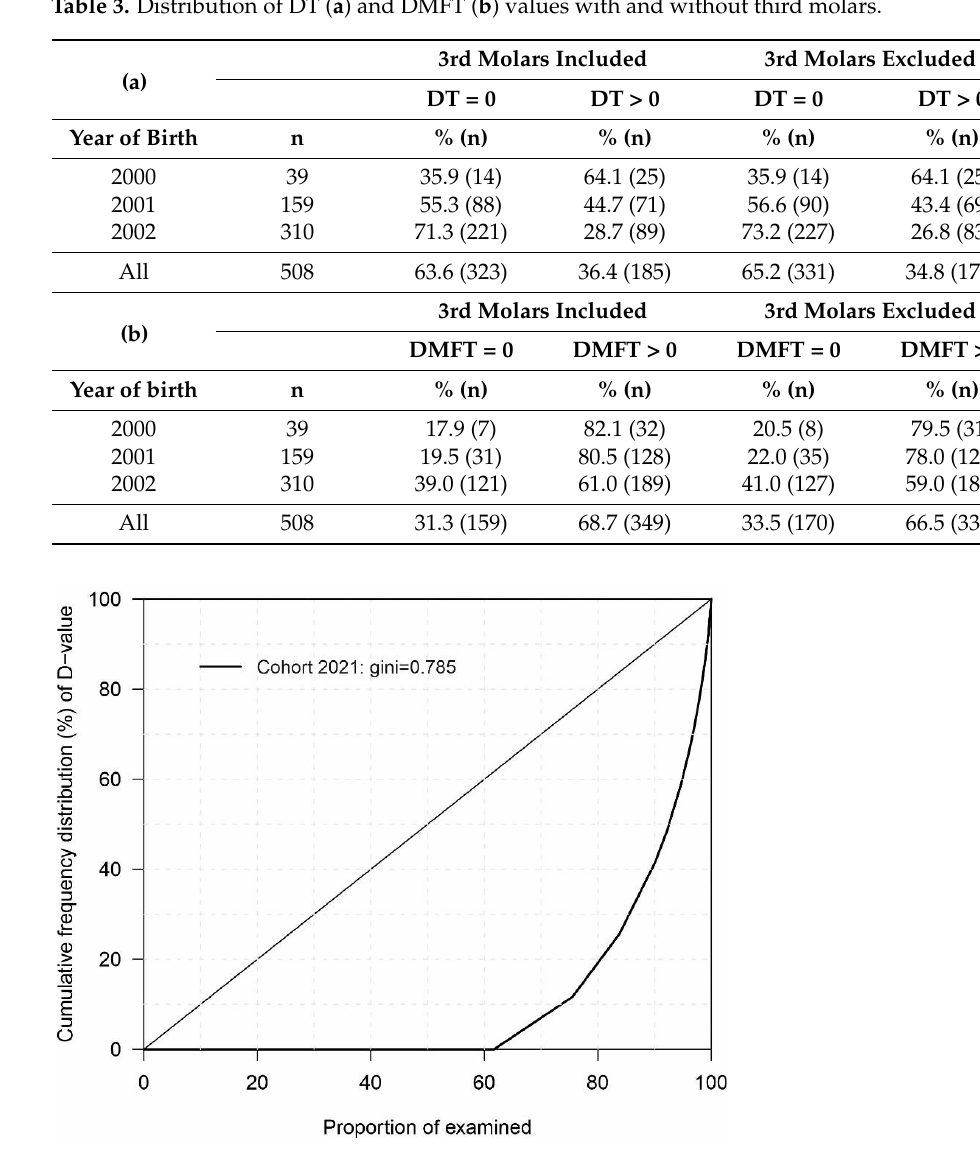
Table 4. Distribution of BEWE score values with and without third molars. BEWE Score Year of Birth